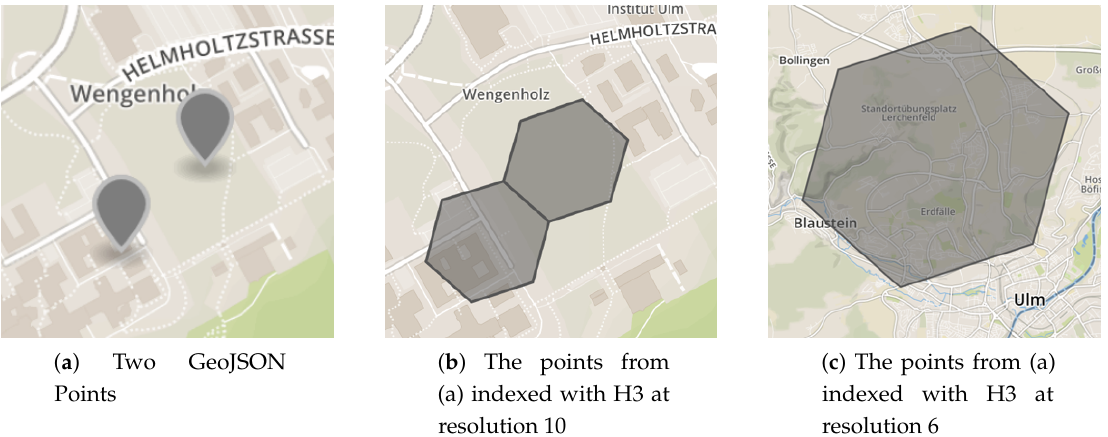
Figure 4. GeoJSON points and their respective H3-indexed polygons at different resolutions (Screenshots from